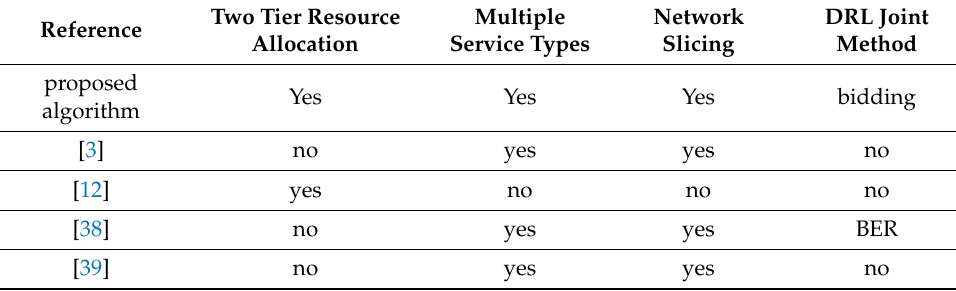
Table 1. Comparison with reference